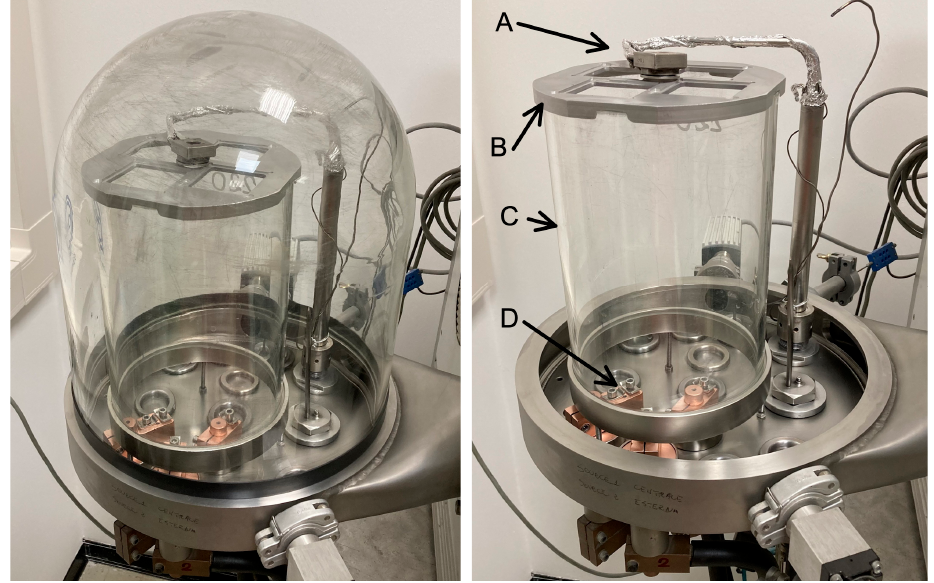
Figure 2. The small evaporator with the Pyrex glass vacuum chamber 30 cm in diameter. (A): quartz scale. (B): support for substrates. (C): Pyrex glass cylinder to limit the evaporation spread. (D): electrodes/holders for the crucible.